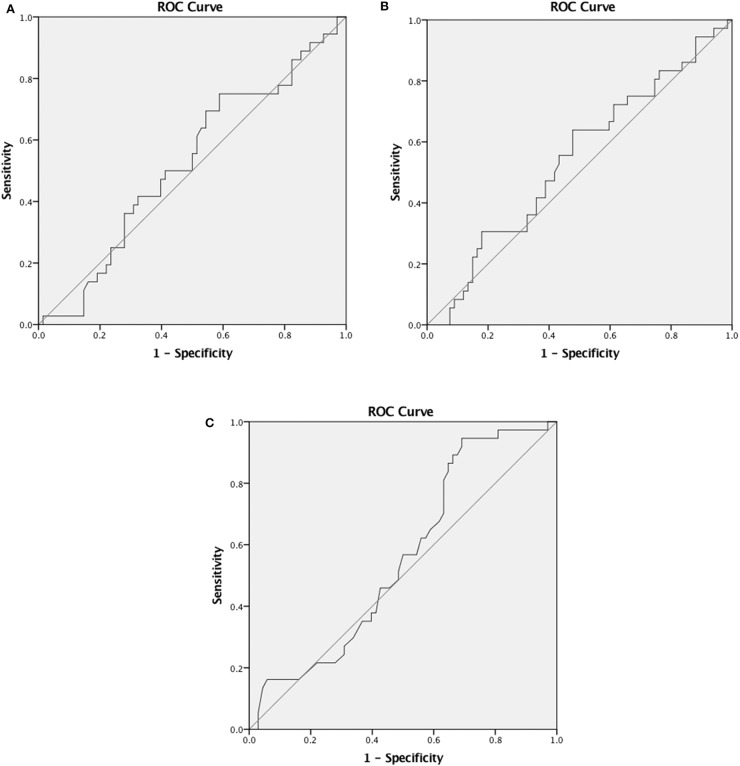
(A) Receiver operating characteristic (ROC) curves for predicting complete recovery (GOS 8). Area under the curve (AUC) for T-tau, 0.56 (95% CI 0.45–0.67). (B) ROC curves for predicting complete recovery (GOS 8). AUC for Aβ40, 0.52 (95% CI 0.41–0.64). (C) ROC curves for predicting complete recovery (GOS 8). AUC for Aβ42, 0.54 (95% CI 0.43–0.63).